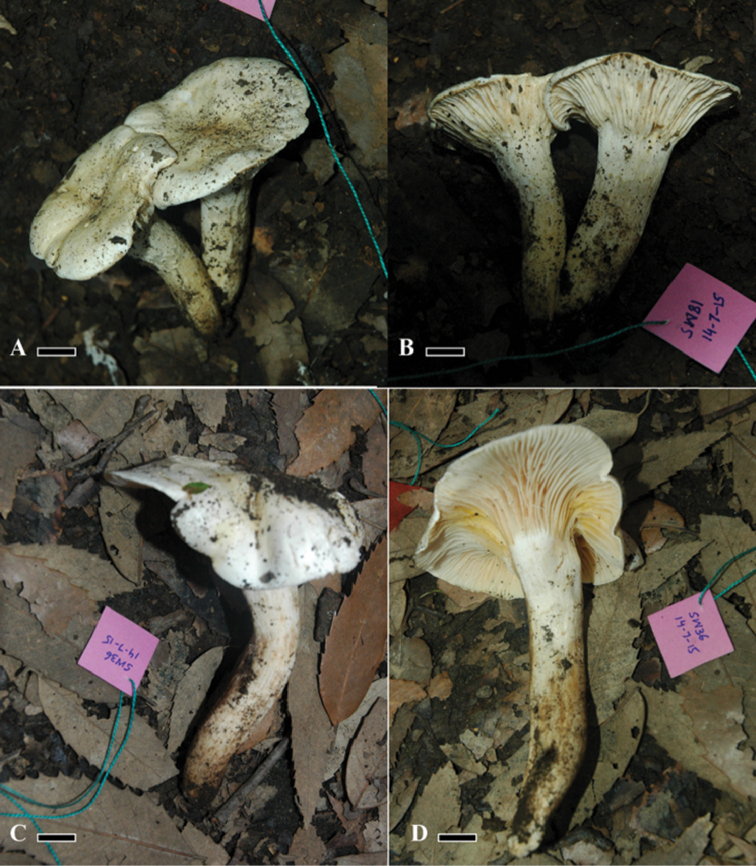
Morphology of Hygrophorusalboflavescens (Holotype). A–D Basidiomata A, BLAH35244; FLAS-F-59457 C, DLAH35243. Scale bar: 1.5 cm.